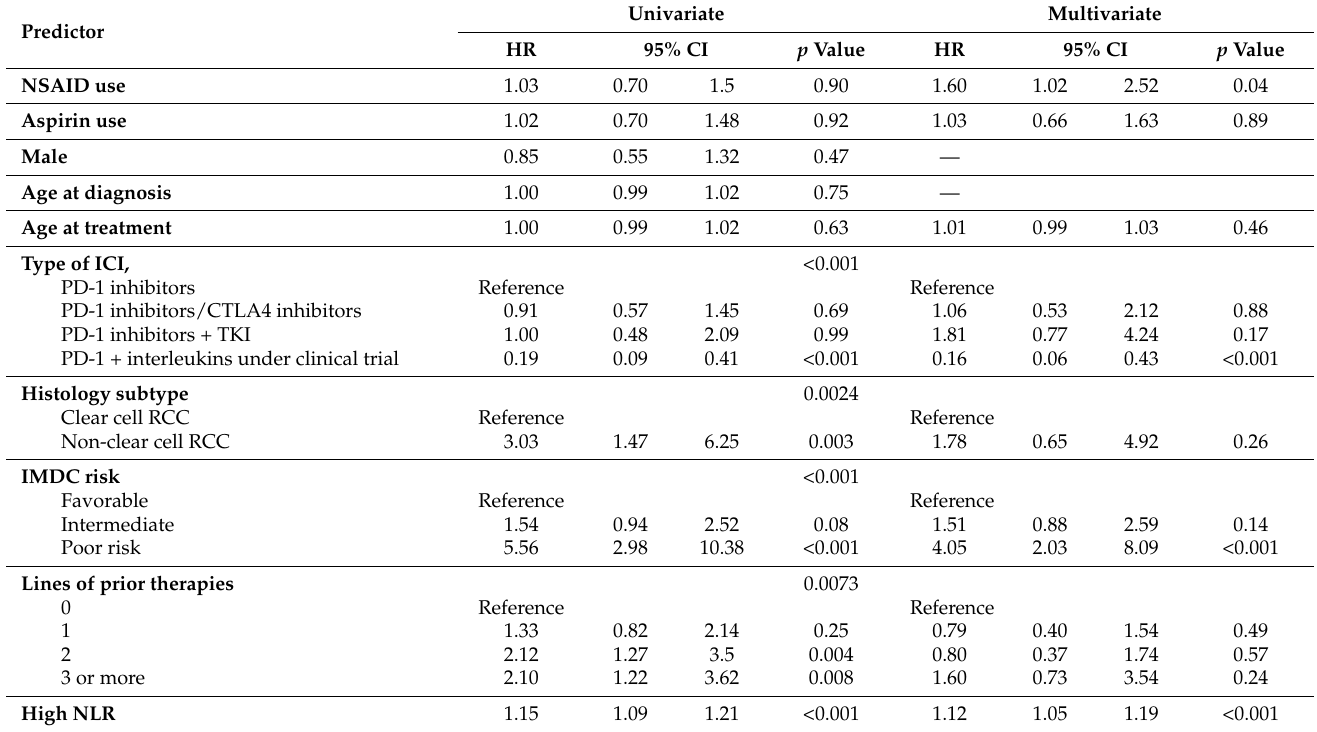
Table 2. Univariate and Multivariate Analysis of Factors Associated with Overall